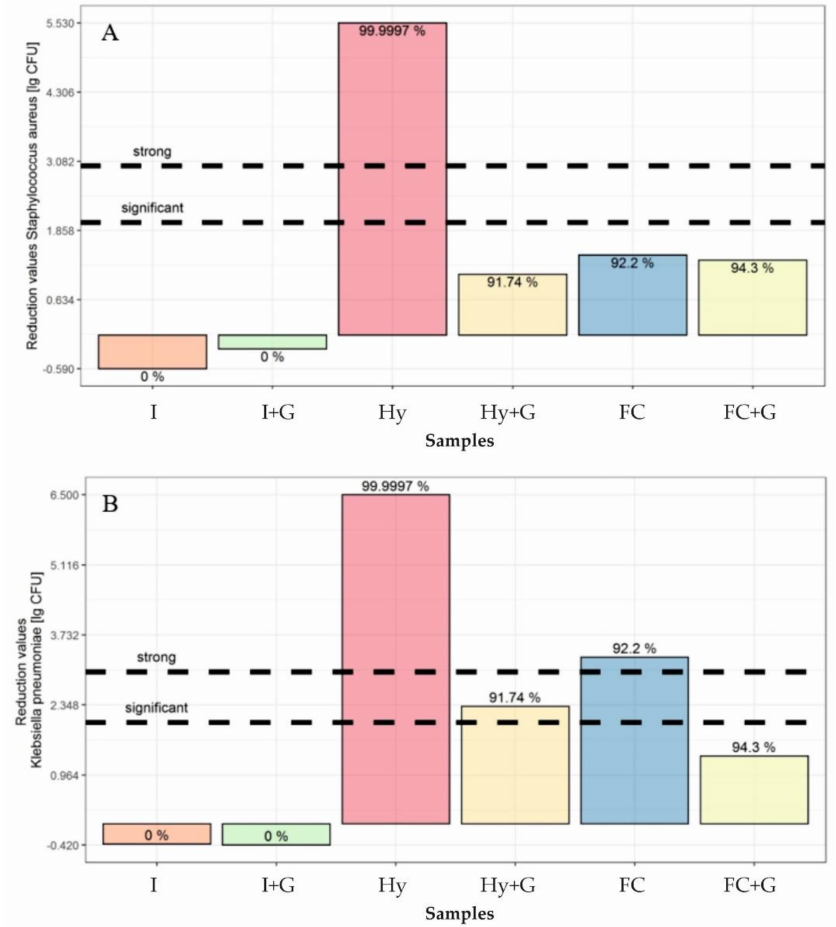
Figure 4. The assessment of antibacterial activity for the different non-modified and modified nonwovens is shown, namely for (I) initial state, (I + G) initial state and graphene, (Hy) hydrophilic agent, (Hy + G) hydrophilic agent and graphene, (FC) functional coating and (FC + G) functional coating and graphene. ( A ) The antibacterial assessment by applying the Staphylococcus aureus bacteria strain, and ( B ) applying the Klebsiella pneumoniae bacteria strain on the nonwoven